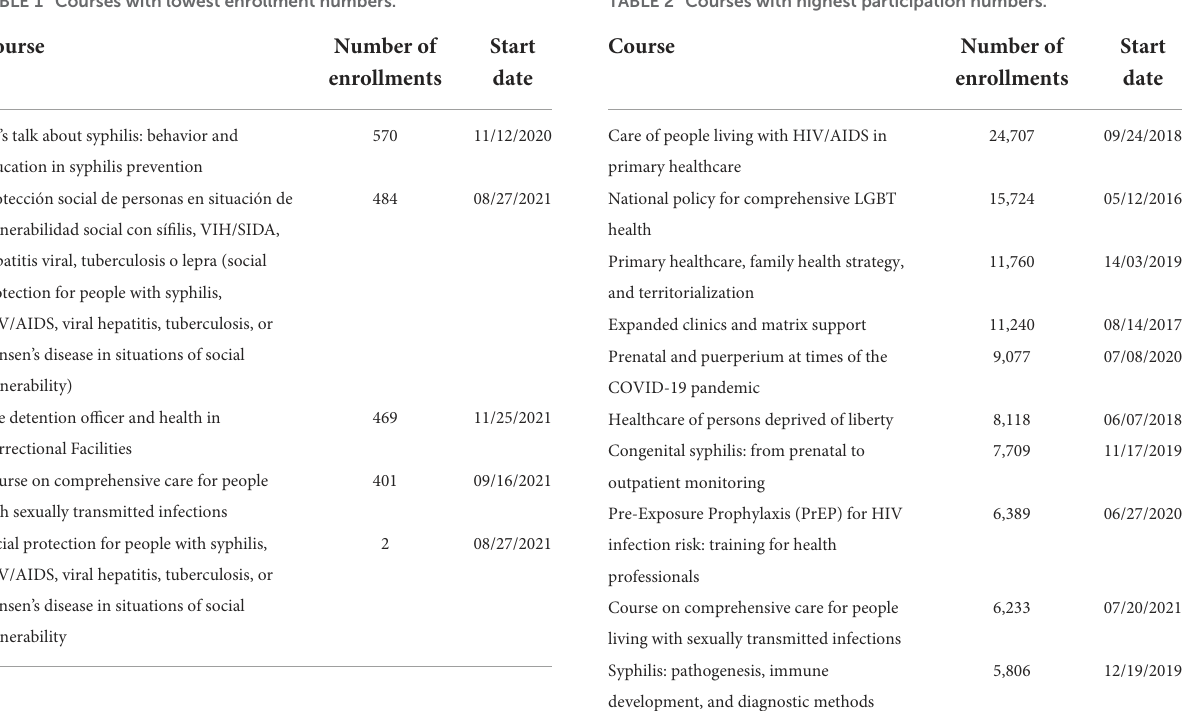
TABLE 1 Courses with lowest enrollment numbers. TABLE 2 Courses with highest participation